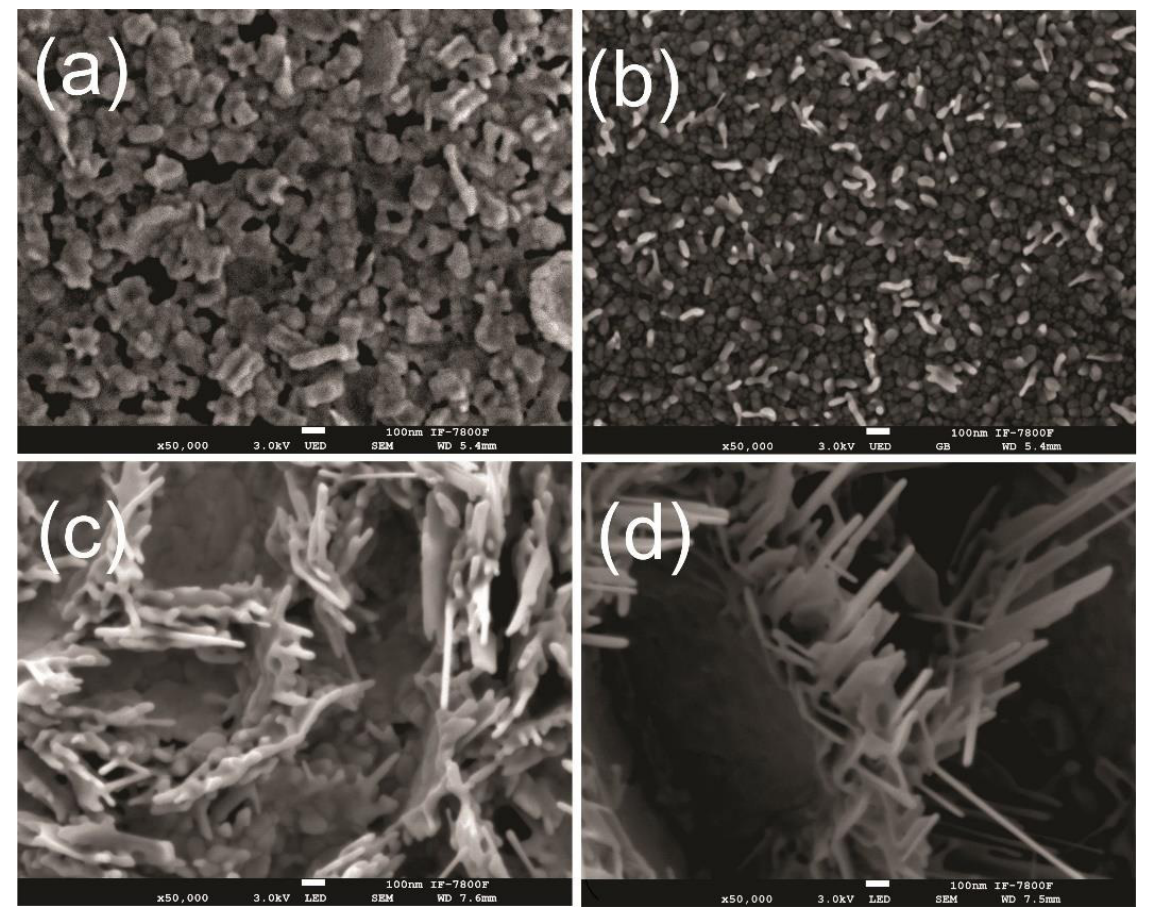
Figure 5. ZnO morphologies as a function of the Zn film thickness: ( a ) A1Ox; ( b ) 3MOx; ( c ) 6MOx; ( d )